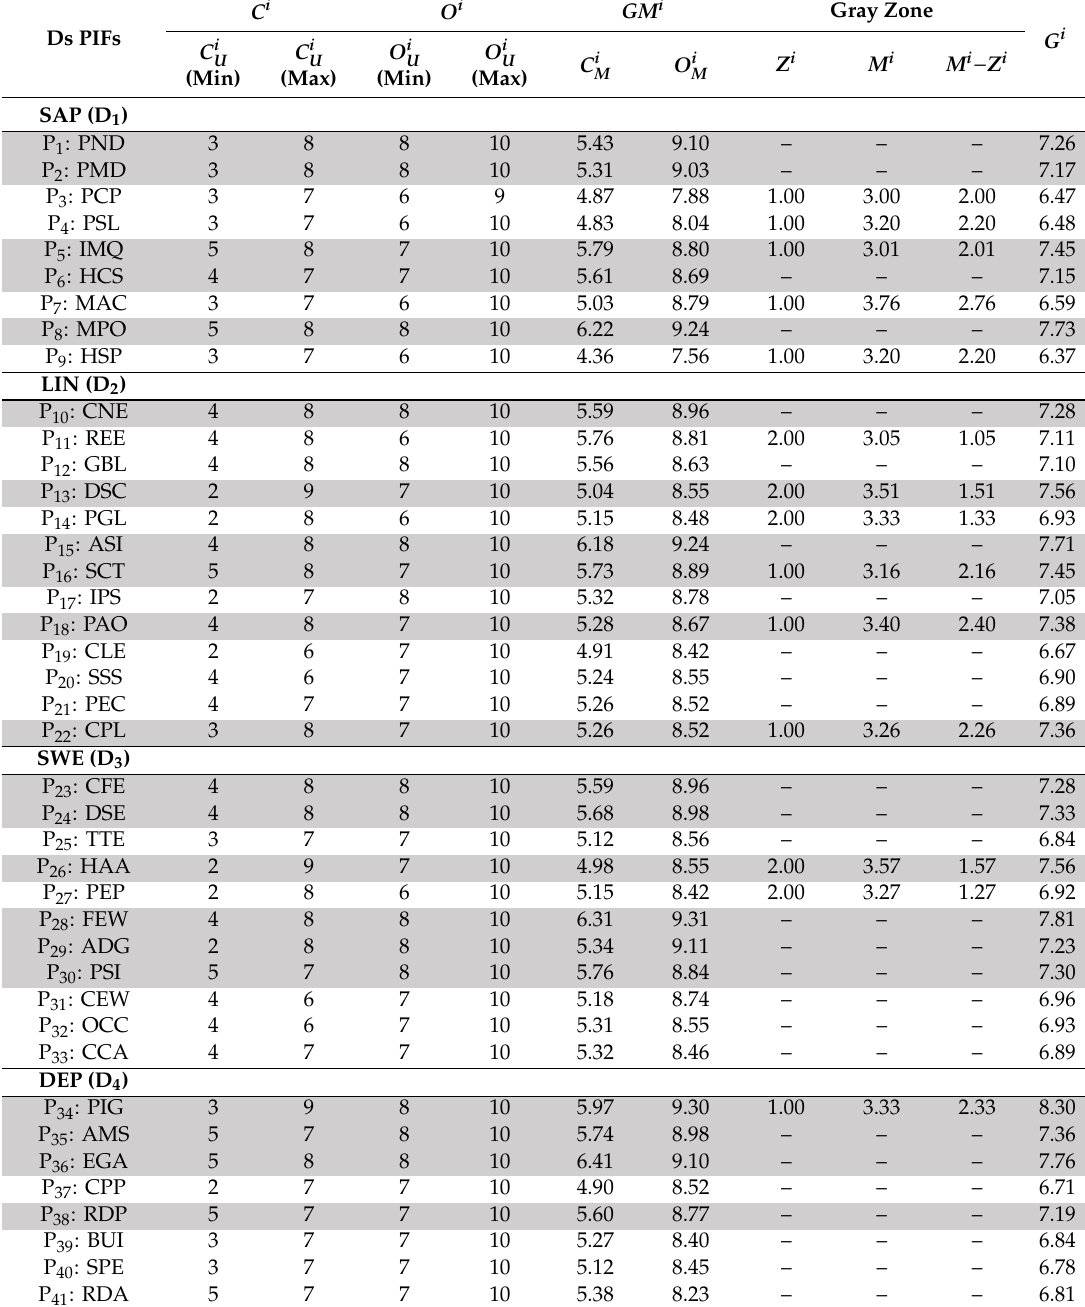
Table 3. Results of the extraction of